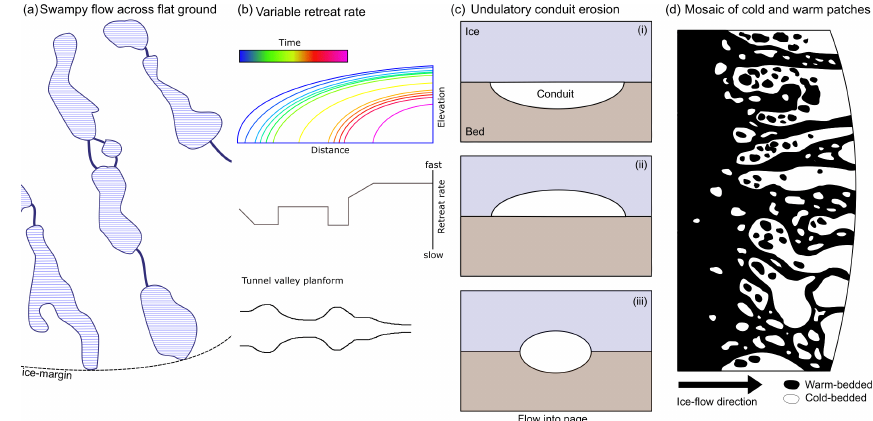
Figure 15. Cartoons showing four theories to explain the downstream variation in tunnel valley width. (a) Swampy ground (blue stipples) and overspill channels (blue lines) associated with water flow across very flat ground. In such a flat landscape tunnel valleys are able to easily expand laterally, in response to small changes in water flux, and there is little impetus for rapid vertical erosion due to shallow hydraulic gradients. (b) Variable retreat rate. When the rate of retreat is slow there is more time for valleys to grow and widen, whereas more rapid retreat will produce narrower segments. (c) Undulatory conduit erosion. In this theory the width of the channel eroded into sediment depends upon the competition between erosion down into the sediment (canals) vs. melting up into the ice (R-channel) (see Fowler, 2011; Livingstone et al., 2016). Note that each of the conduits (i–iii) have roughly the same area, but that in (ii) no channel forms and in (iii) the channel width is roughly half that of (i). (d) Tunnel valley formation is modulated by the basal thermal regime (modified from Hughes, 1995). Channels are able to develop more easily across warm sediment patches, and the mosaic of cold and warm sediment patches results in variations in